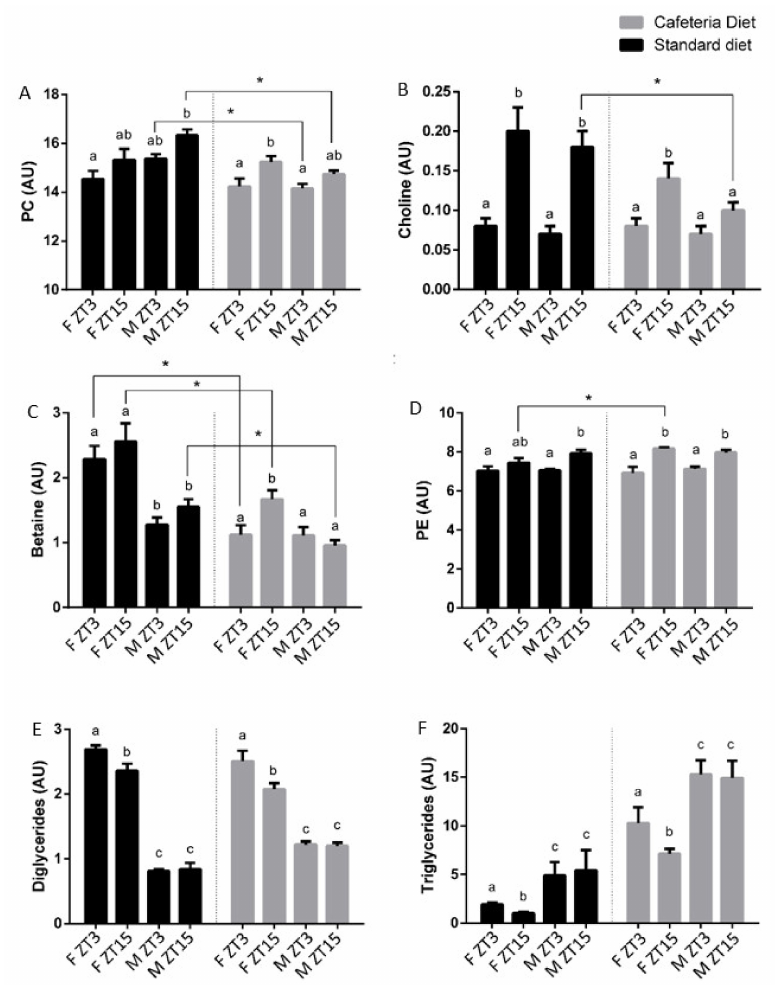
Figure 2. The concentration of the metabolites in the liver of female and male Fischer 344 rats fed with cafeteria or standard diet: phosphatidylcholine ( A ), choline ( B ), betaine ( C ), phosphatidylethanolamine ( D ), diglycerides ( E ), and triglycerides ( F ). Data are expressed as the mean ± SEM ( n = 8). abc Mean values with unlike letters were significant di ff erent among groups (one-way ANOVA and Duncan’s post hoc test). * denotes a significant di ff erence between groups ( p < 0.05; t-Student). PC, phosphatidylcholine; PE,